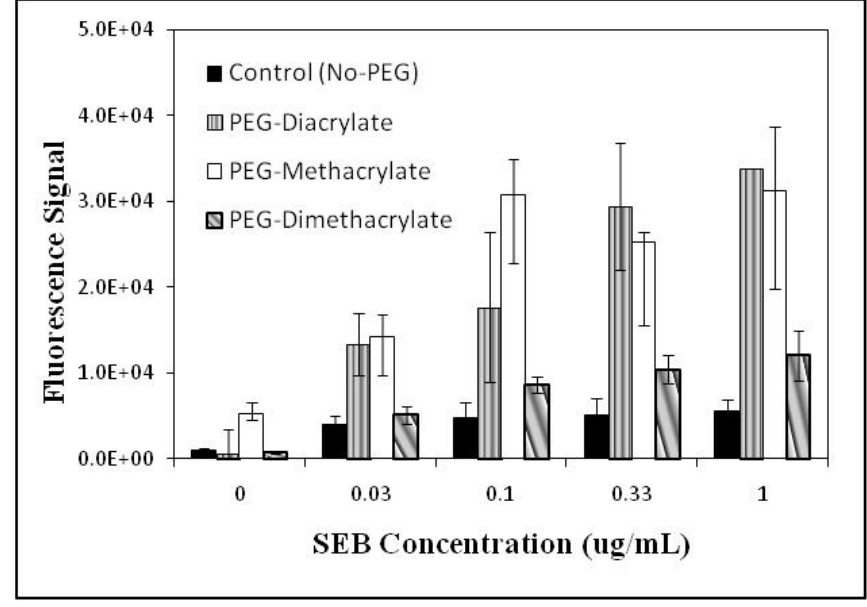
Figure 4. Comparison of net fluorescence signal responses obtained in sandwich immunoassays using control (no PEG) and three different PEG-incorporated hydrogels. The three PEG candidates ( ), PEG-diacrylate ( ), PEG-methacrylate and ( ) PEG- dimethacrylate were incorporated into galactose-based polyacrylate hydrogels. Rabbit anti- SEB (capture antibody) was bound within the hydrogel and fluorescence was obtained with Cy3-labeled sheep anti-SEB (tracer molecule). Values reported represent replicates of six (±